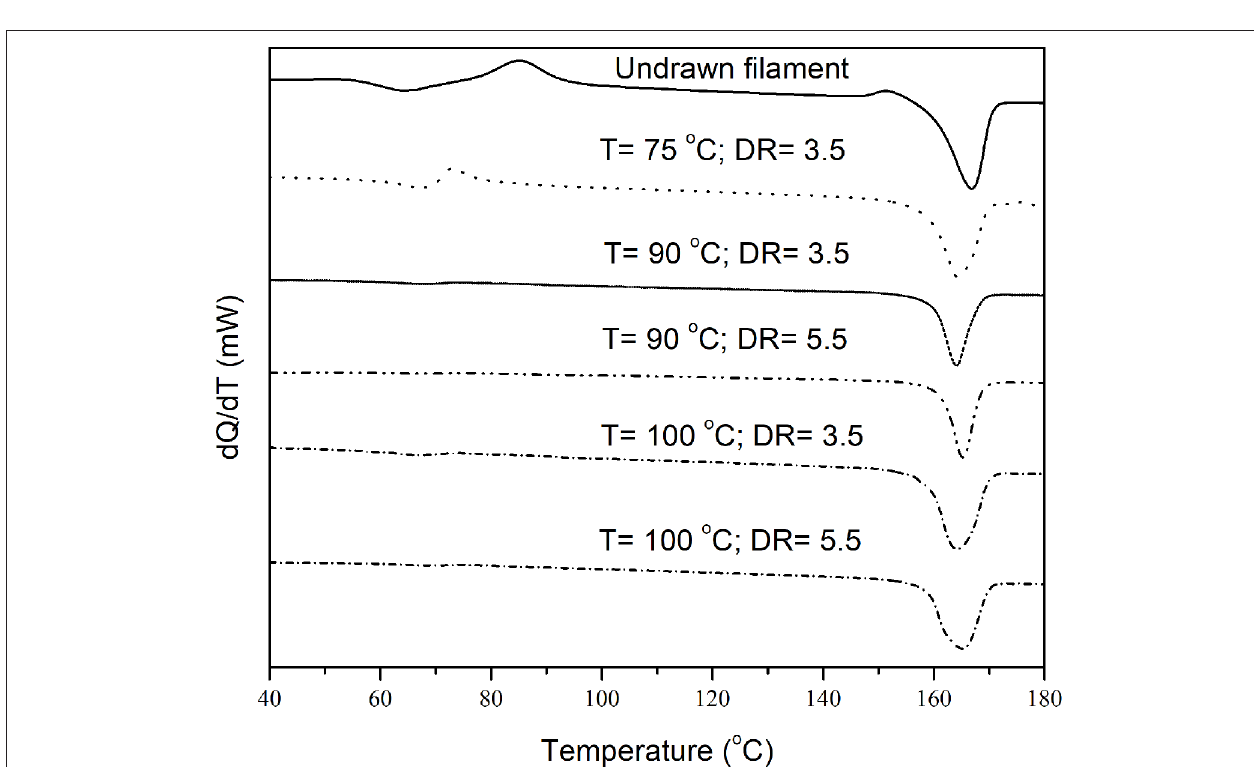
FIGURE 8 | DSC heating scans for the Cu-filled PLA undrawn filament and the filaments drawn at different draw ratios and drawing temperatures.